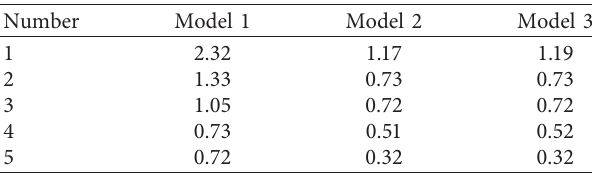
Table 4: Period of three finite element models (units: s).